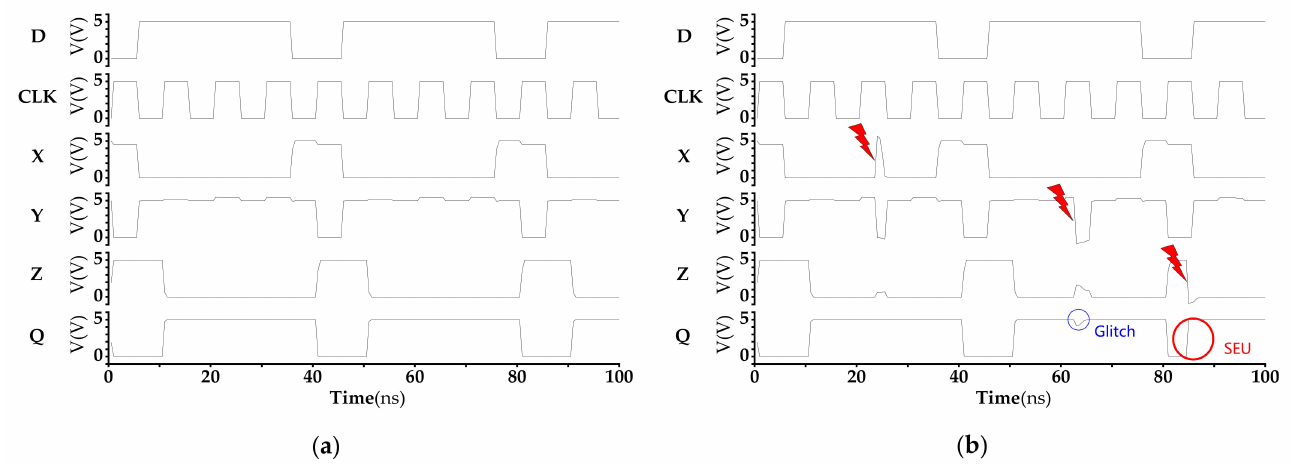
Figure 13. TSPC-Quatro: ( a ) simulation waveform of TSPC-Quatro without SETs; ( b ) simulation waveform of TSPC-Quatro with